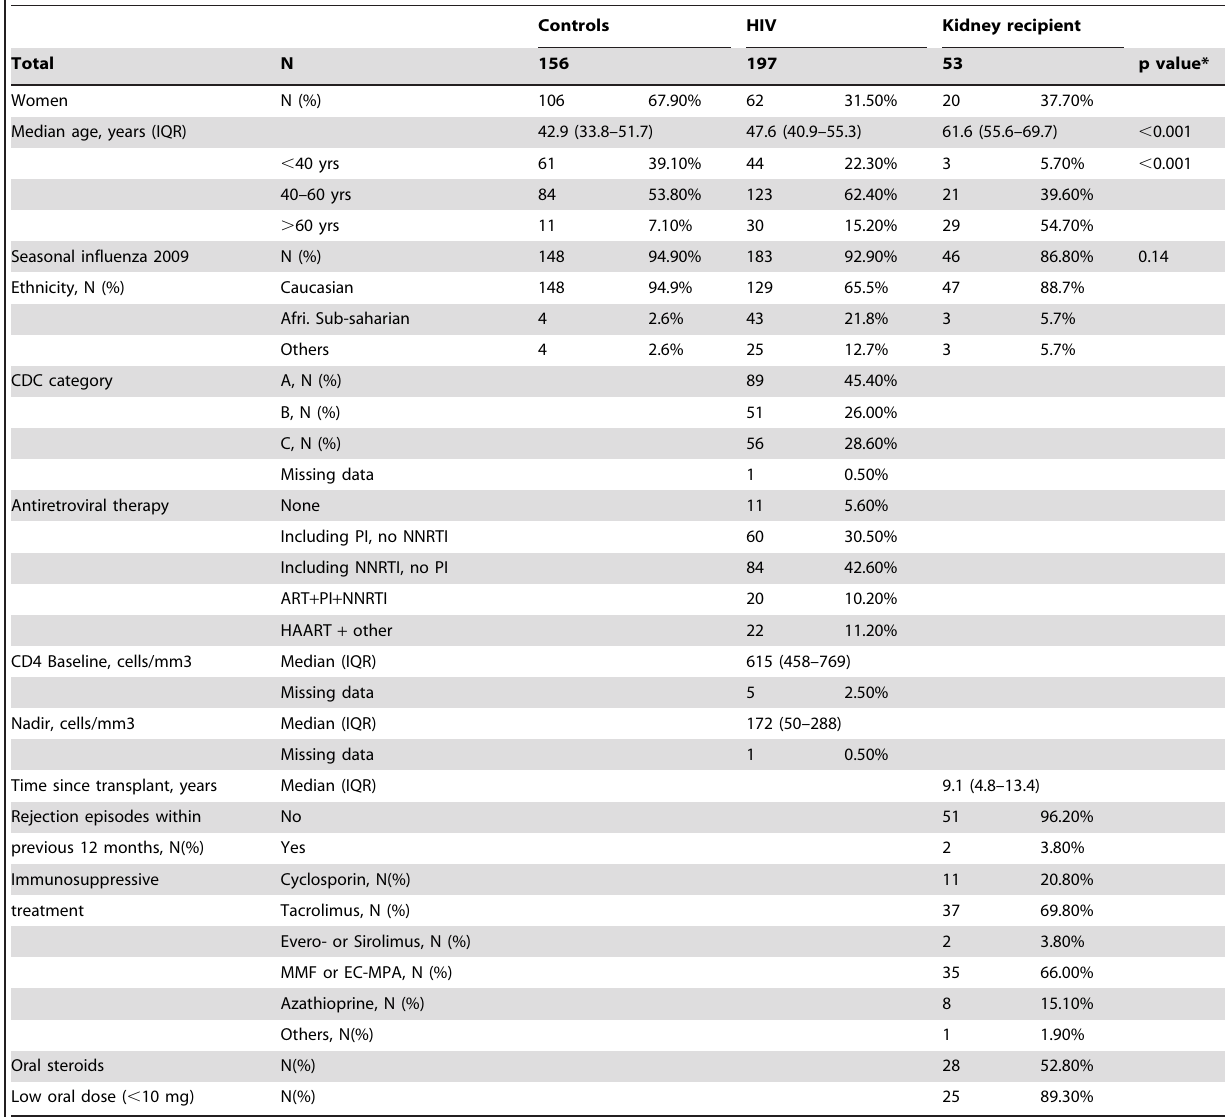
Table 1. Baseline